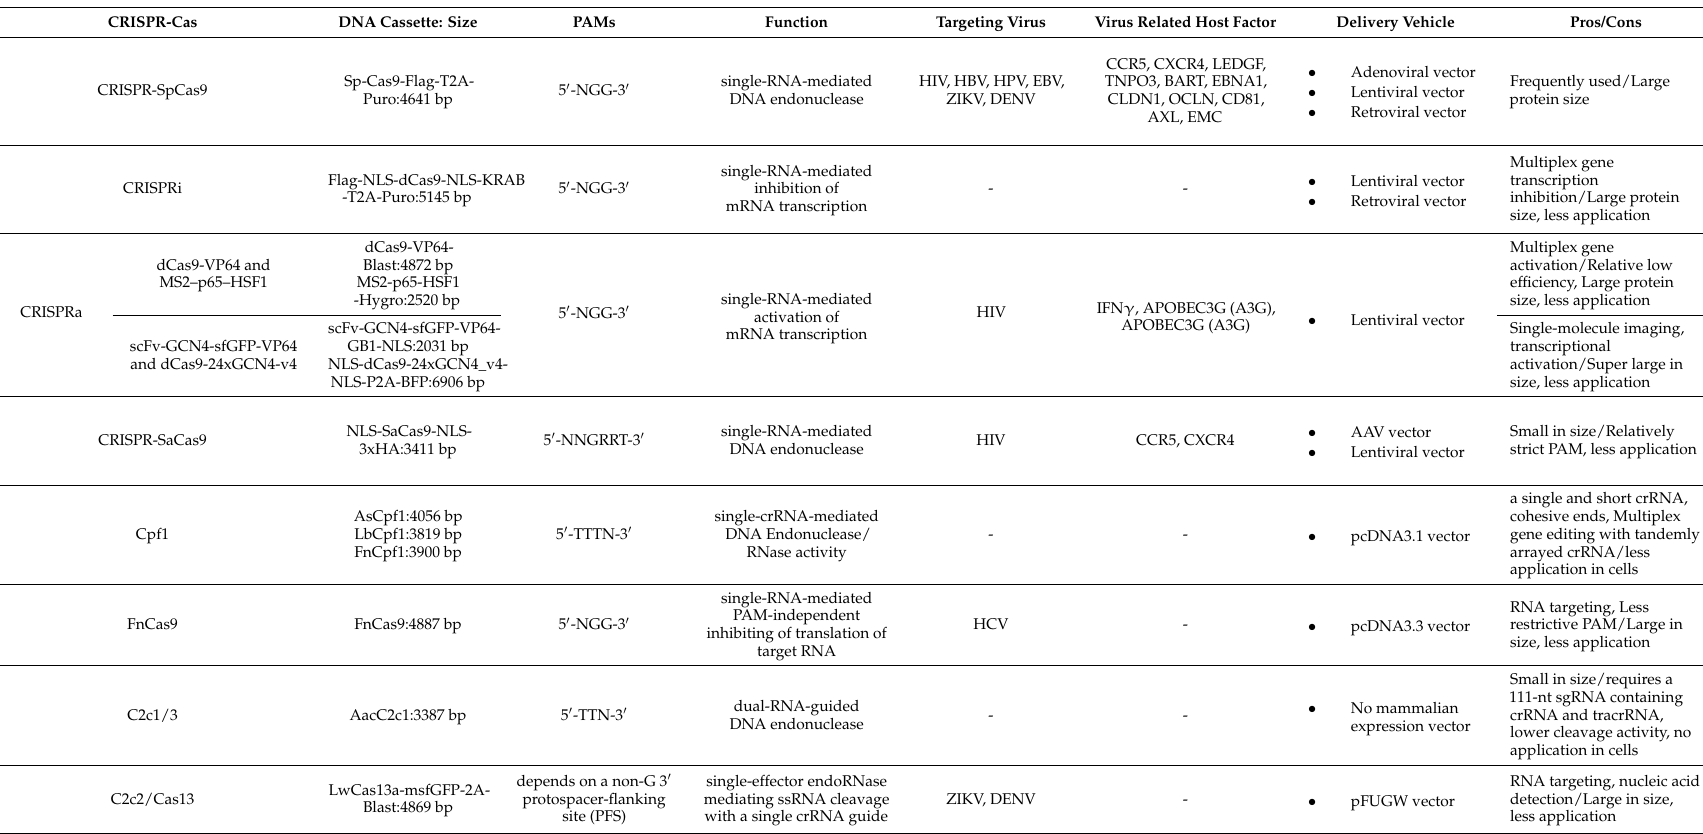
Table 1. Comparison of different CRISPR-Cas systems in eukaryotic